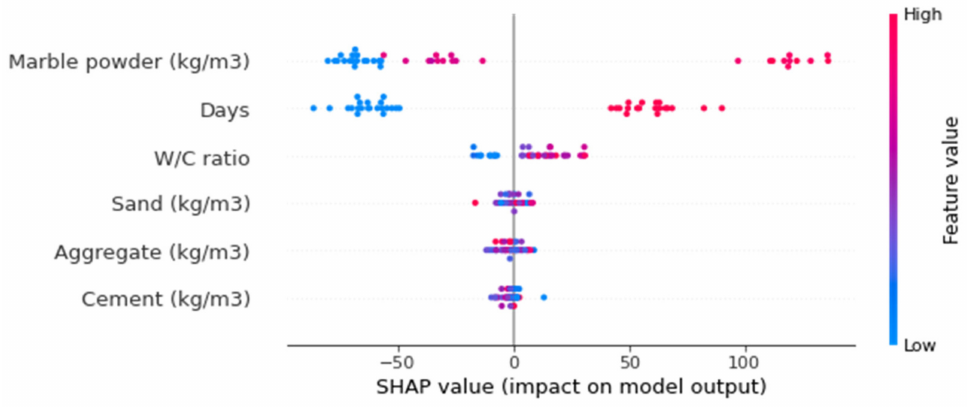
Figure 16. SHAP plot.